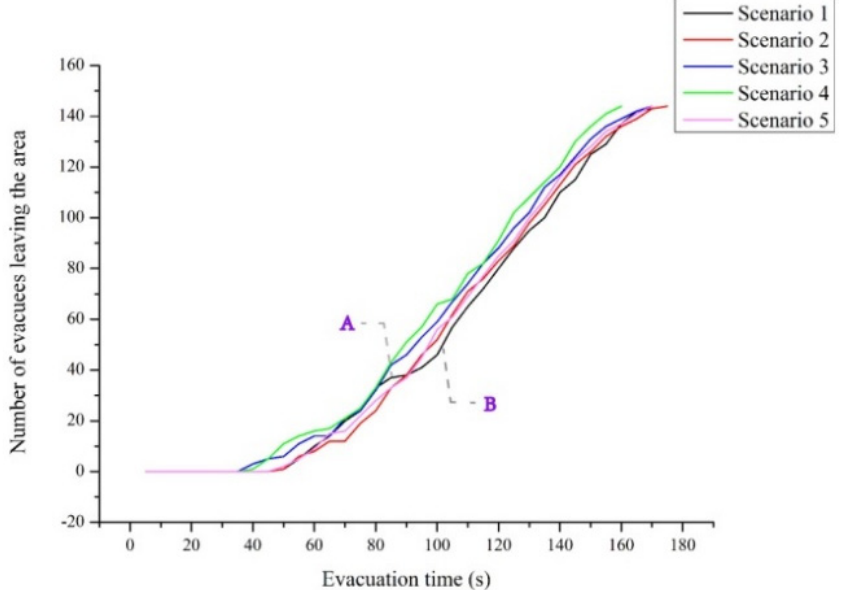
Figure 15. Relationship between the number of evacuees and evacuation time. The process between points A and B represents the evacuation bottleneck in Scenario 1.